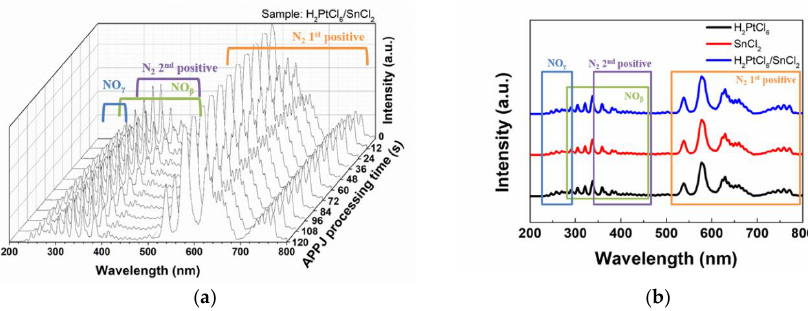
Figure 2. ( a ) OES evolution during APPJ processing of mixed H 2 PtCl 6 /SnCl 2 precursors. ( b ) OES when processing H 2 PtCl 6 , SnCl 2 , and mixed H 2 PtCl 6 /SnCl 2 precursors using nitrogen APPJ.